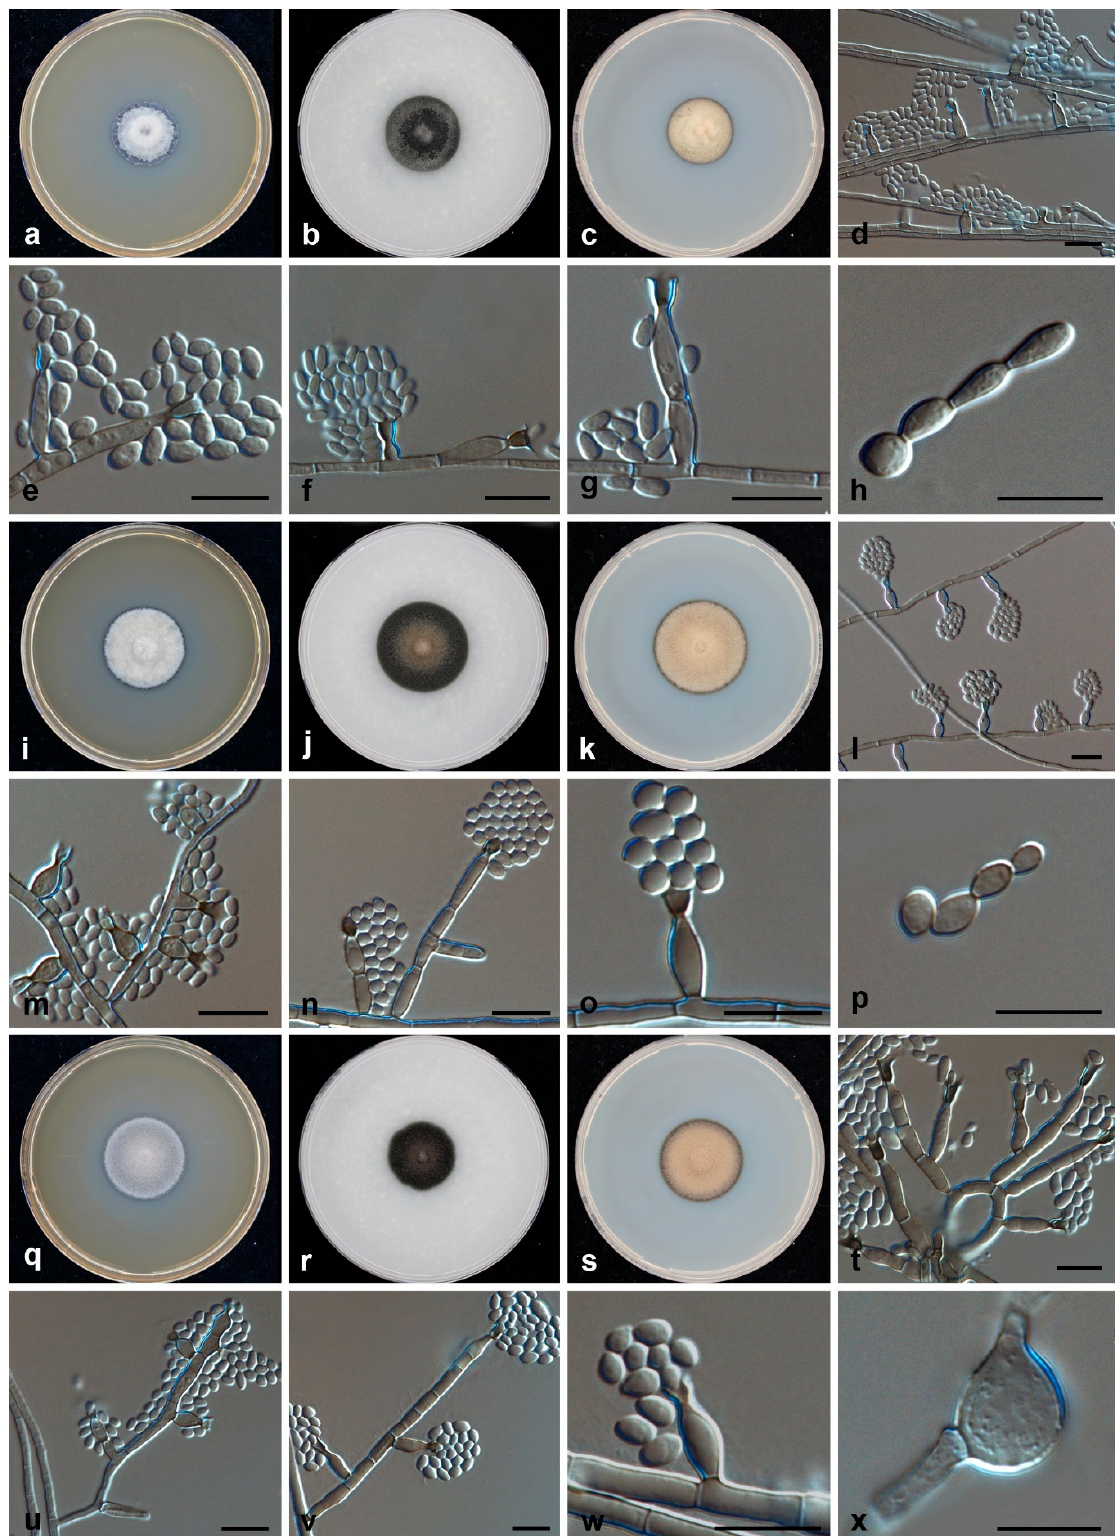
Figure 2. Growth and micromorphology of the clinical isolates. ( a – h ) Phialophora americana ; ( i – p ) Phialophora chinensis ; ( q – x ) Phialophora macrospora . Scale bars = 10 µm.